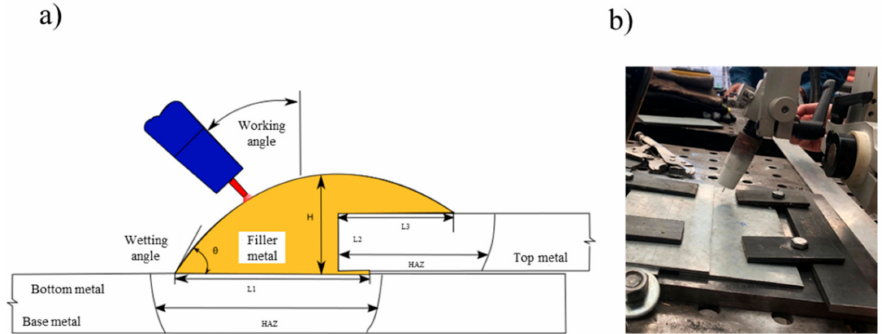
Figure 1. Prior to welding, all the samples were thoroughly degreased with acetone at the edge to be joined; the welding parameters according to the experiments are displayed in Table 2. In this study, two different heat inputs were assessed for both GMAW methods, pulsed and pulsed-brazing; low and high heat input designated as condition C1 and condition C2, respectively.